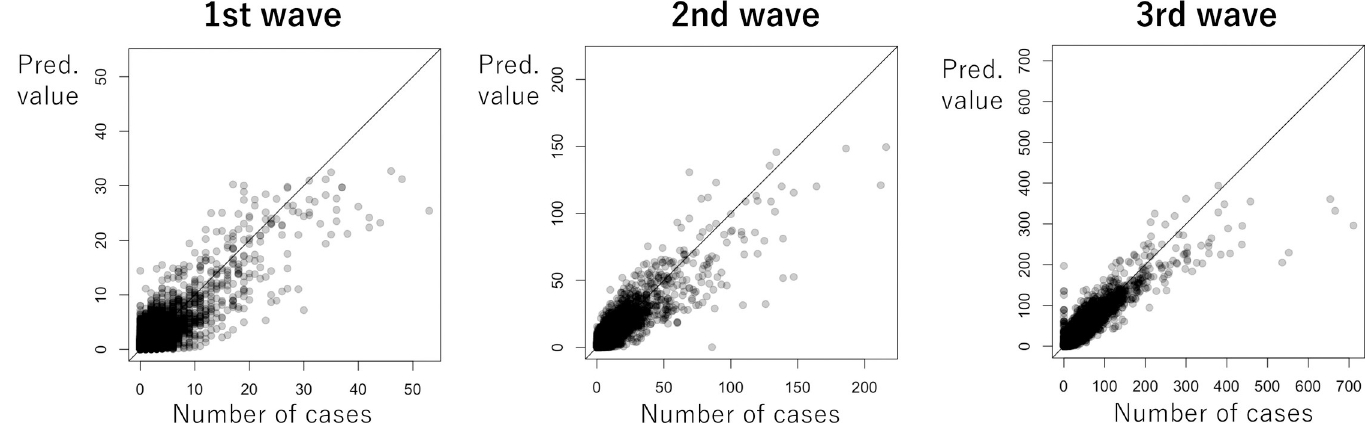
Fig 15. Comparison of the observed and predicted number of cases.